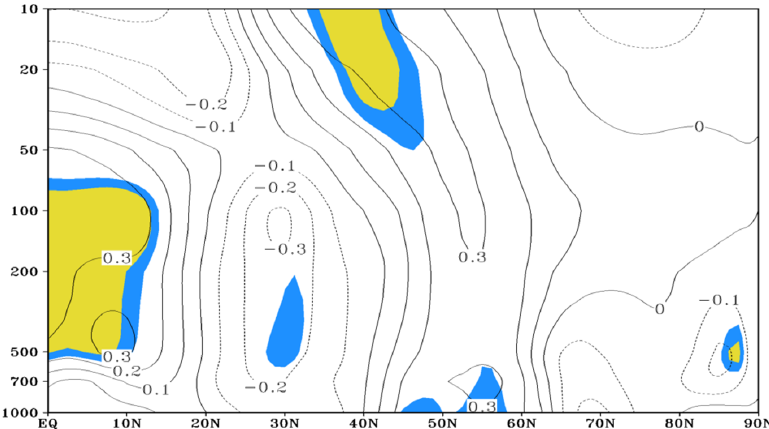
Figure 10. Profile of zonal wind differences in winter between high and low SRF years. Light and heavy shading indicate the regions that passed the 0.1 and 0.05 significance tests, respectively. (Units: latitude is ° N , and the vertical pressure is hPa).